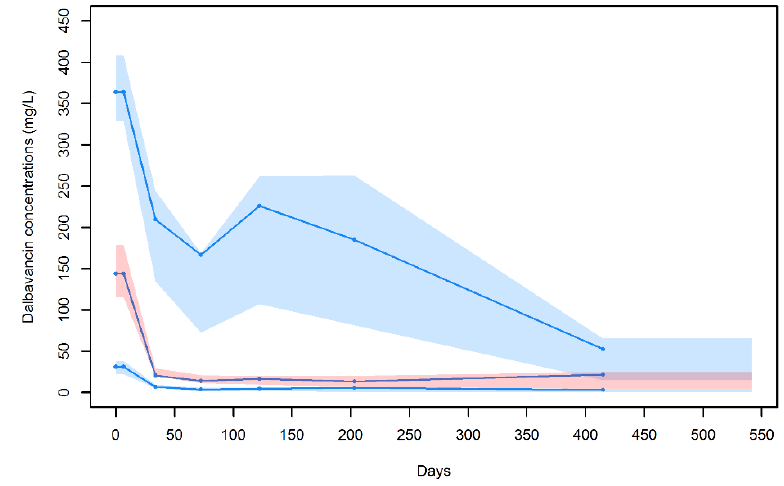
Figure 2. Visual predictive check for the final population pharmacokinetic model. Blue dots are the observed dalbavancin concentrations; blue lines represent the median, 10th and 90th percentiles of the observed values; and shaded areas are the prediction intervals for the median (red central area) and 10th and 90th percentiles (light blue lower and upper areas).